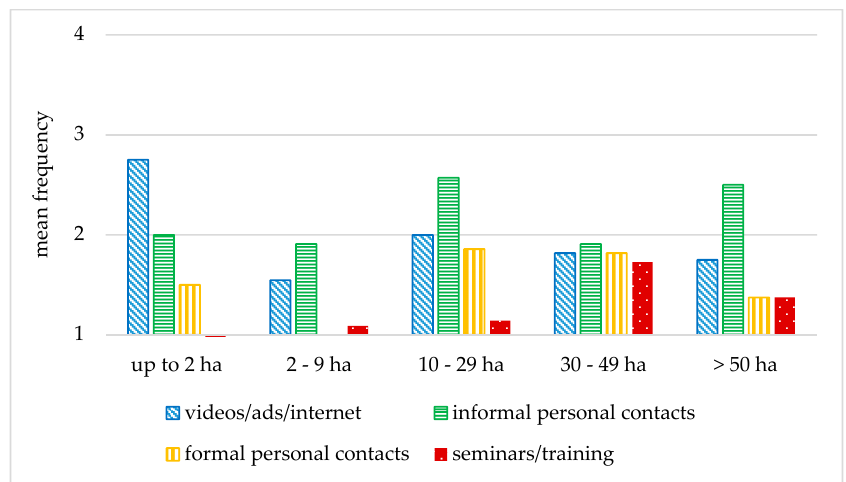
Figure 3. Mean ratings of frequency of use of the different information sources per different farm sizes.